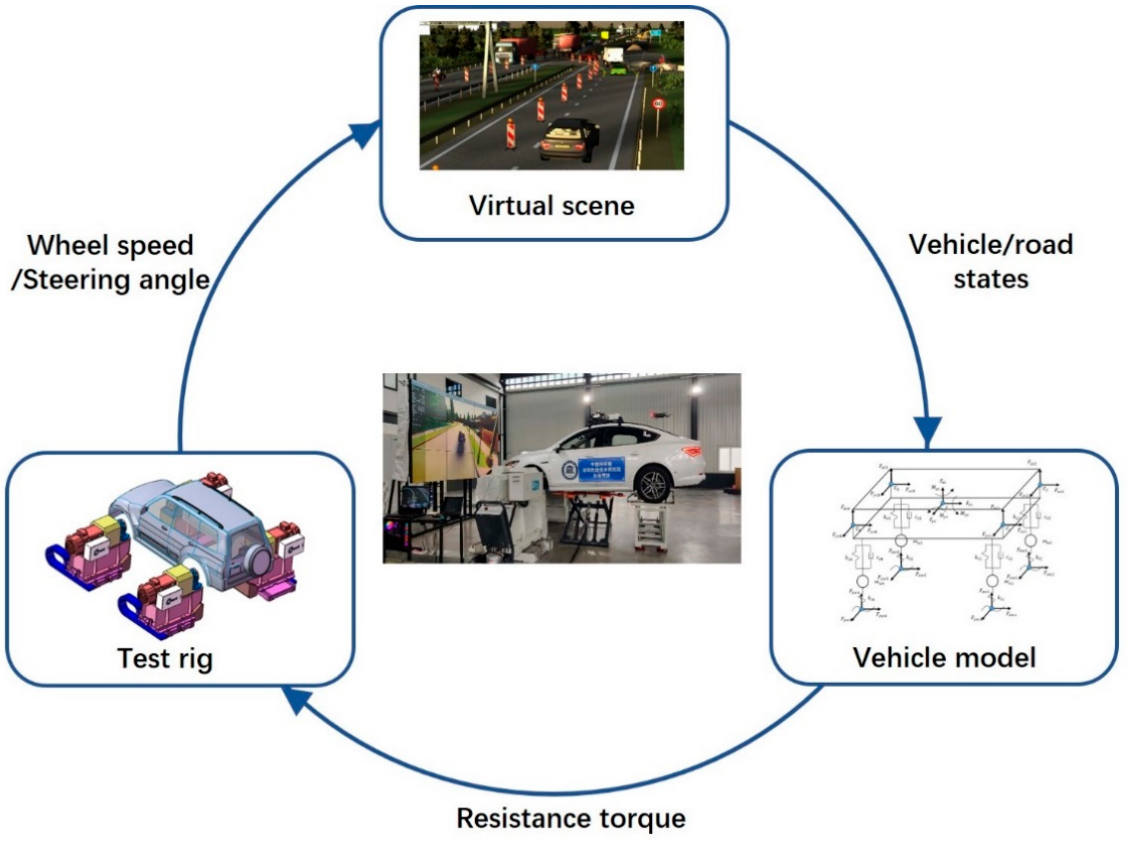
Figure 1. Autonomous driving test rig.